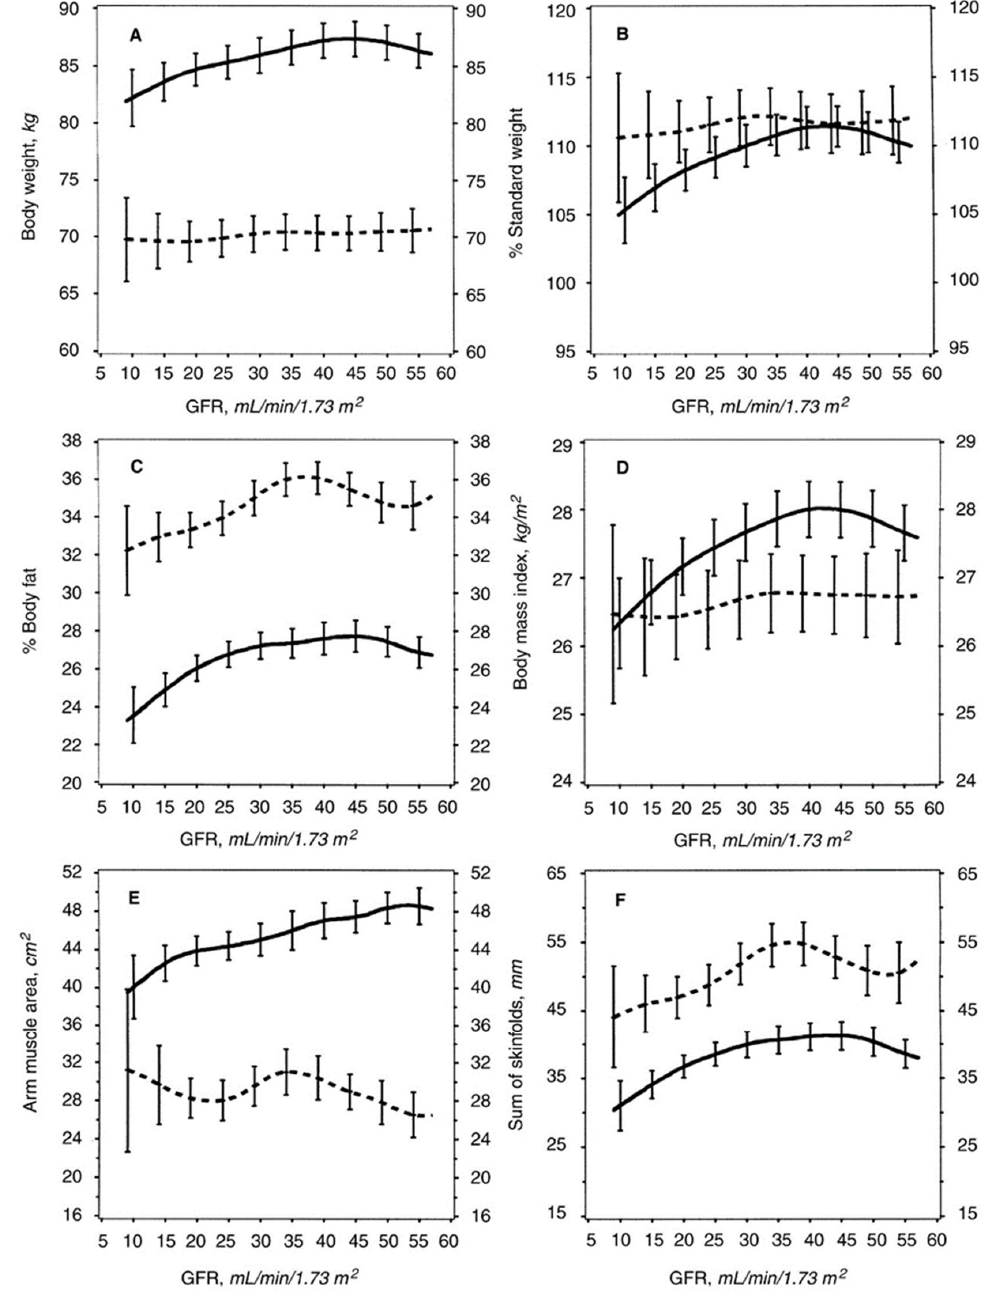
Figure 1. Mean levels of some anthropometric measures of nutritional status as a function of GFR.